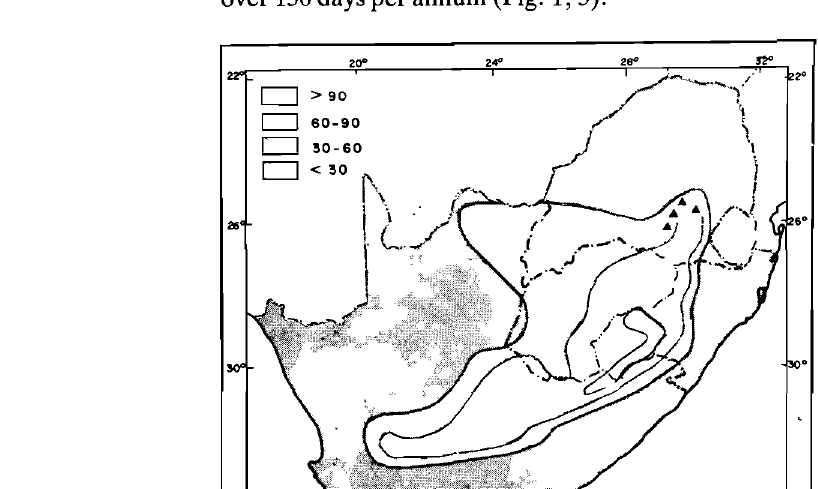
Fig. 3. Annual number of days of